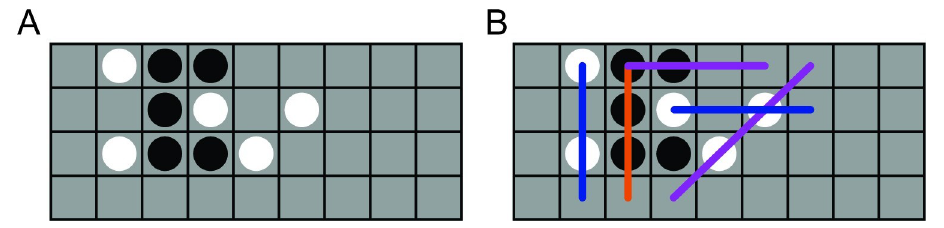
Fig 8. Four-in-a-row task. A . Example board configuration in the 4-in-a-row task, in which two players alternate placing pieces (white or black circles) on a 4-by-9 board (gray grid), and the first player to get 4 pieces in a row wins. In this example, the black player can win by placing a piece on the square on the bottom row, third column. B . Illustration of features used in the value function of the heuristic search model (Eq 21). For details on the model, see S1 Appendix B.3 and